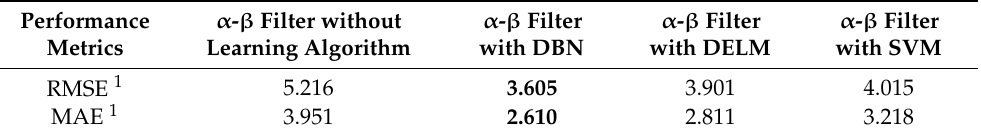
Table 3. The comparison of typical alpha-beta filter and proposed multi-method in terms of RMSE and MAE.